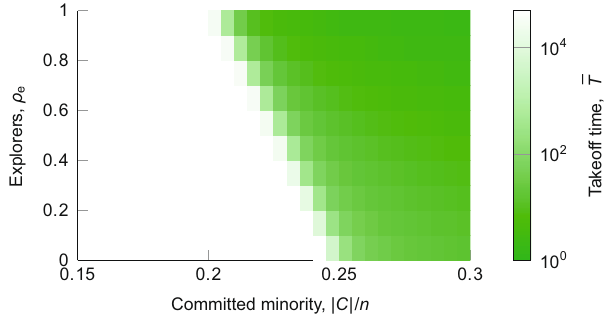
Fig. 5 Monte Carlo estimation of the take-off time for different committed minorities ( j C j = n ) and fractions of explorers ( ρ e ). The heat map identi fi es the delay in the take-off time ( (cid:2) T ) averaged over 200 Monte Carlo simulations for a given fraction of committed minority ( j C j = n ), and of explorers ( ρ e ), for a population of size n = 1000. Each simulation stops at t = 50,000 steps, so that white indicates that the delay in the take